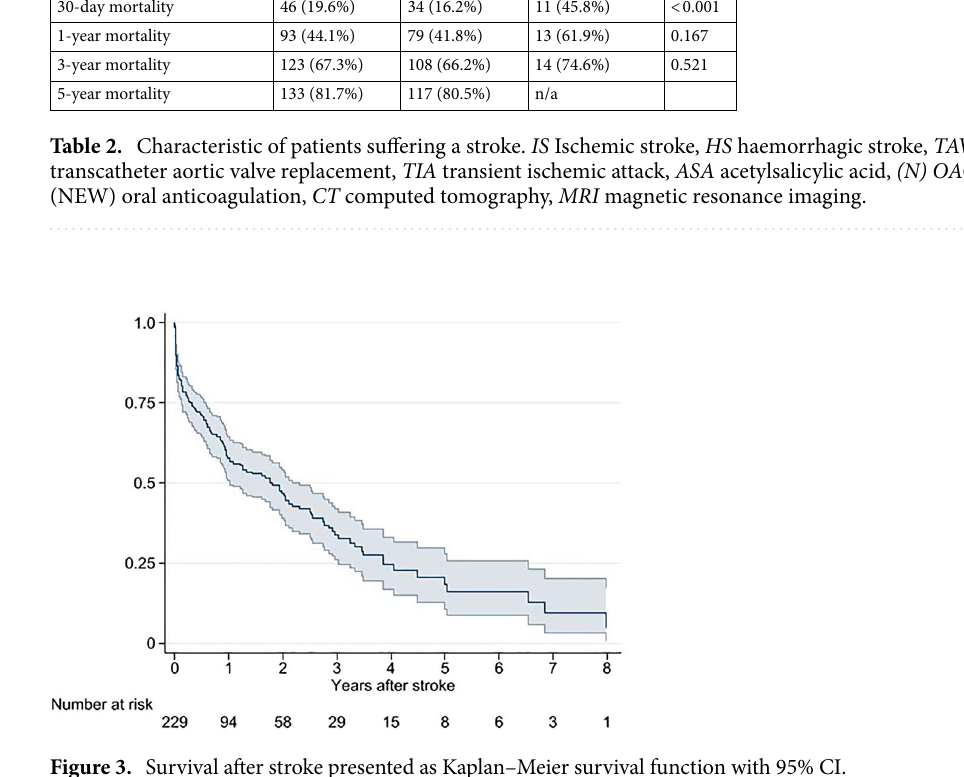
Figure 3. Survival after stroke presented as Kaplan–Meier survival function with 95%